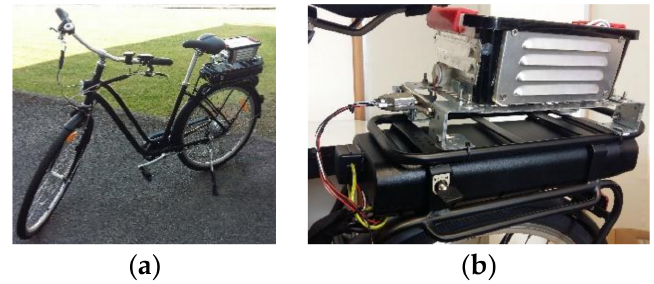
Figure 11. Details of low-cost APMS installation for the intended application: ( a ) Device mounting on e-bike; ( b ) Power supply by the battery of the